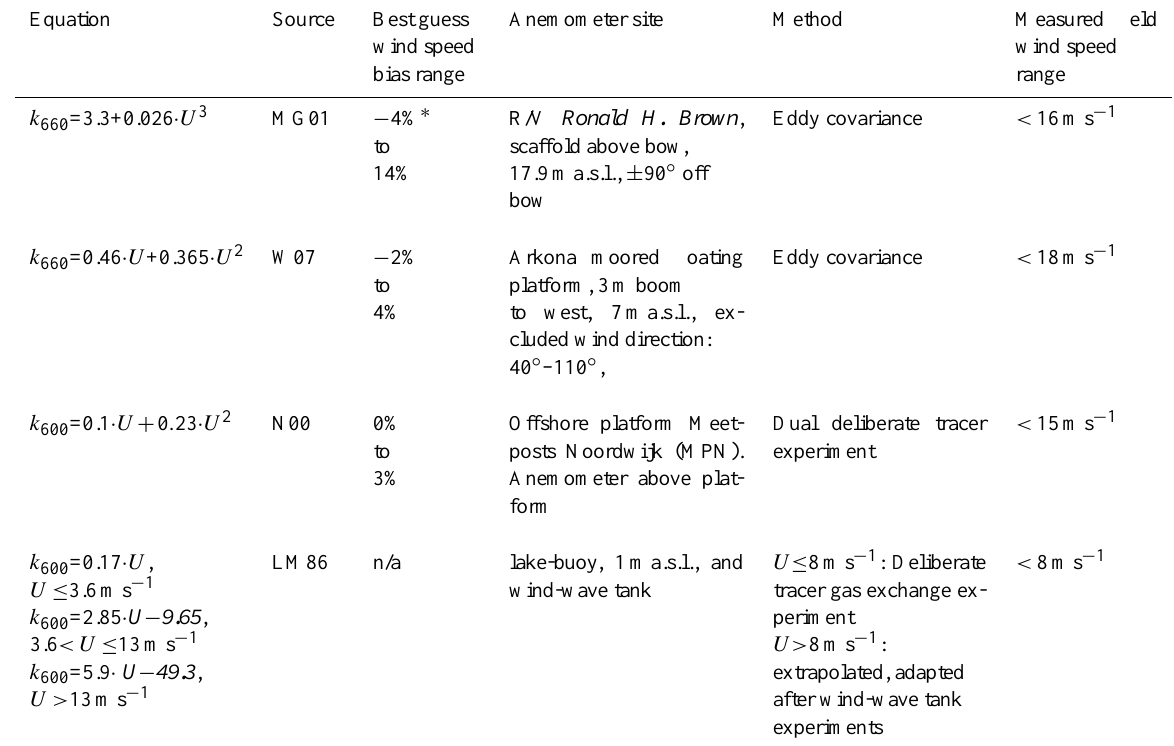
Table 1. Selected gas transfer velocity formulations. W07 is the Weiss et al. (2007), MG01 McGillis et al. (2001b), N00 the Nightingale et al. (2000) and LM86 the Liss and Merlivat (1986) model. The best guess wind speed bias of each platform is estimated based on the platform type, compared to already modeled platforms, and individual applied wind speed quality control, i.e. wind direction limitation. Note that the Schmidt numbers used in these studies varies between 600 and